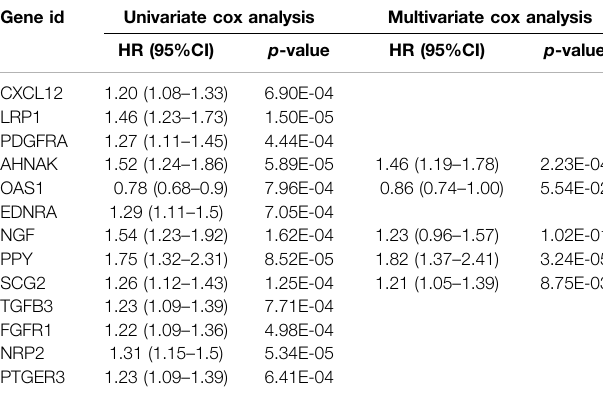
TABLE 2 | Cox regression analysis for screening of immune-related differentially expressed genes (DEGs) affecting the prognosis of bladder urothelial carcinoma